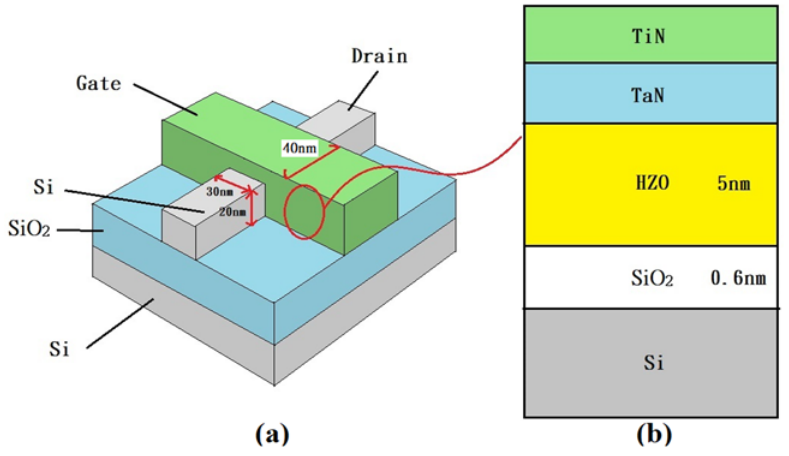
Figure 1. ( a ) Schematic diagram of tri-gate ferroelectric FinFET structure, and ( b ) the related gate stack picture of this fabricated ferroelectric FinFET.